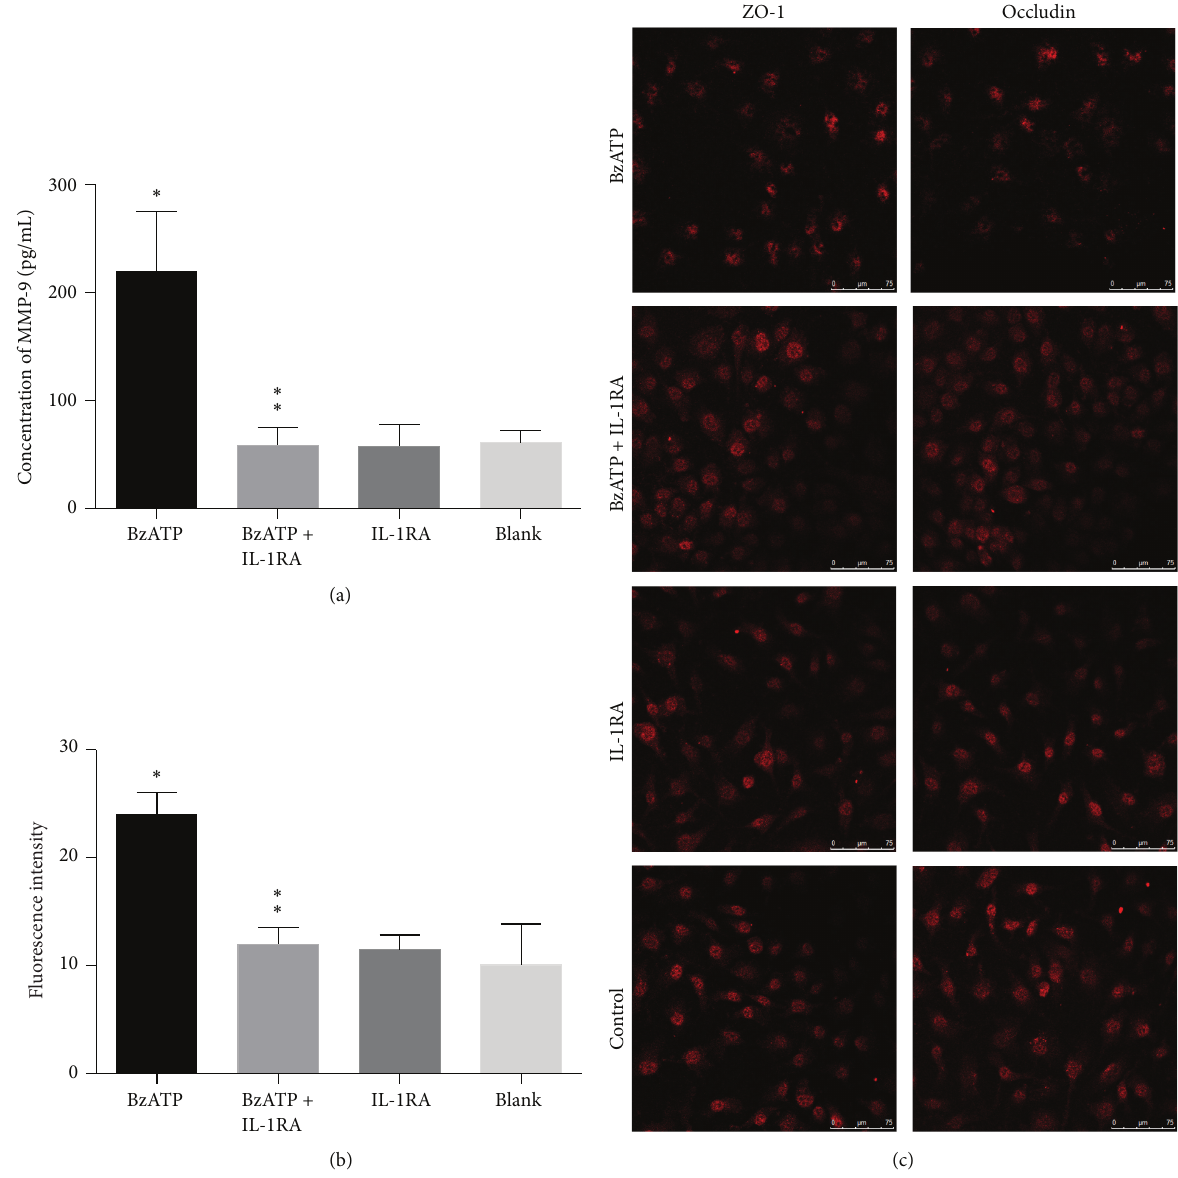
Figure 3: BzATP-induced tight junction disruption and hyperpermeability of endothelial coculture system were attenuated by IL-1 𝛽 inhibition. (a) The levels of MMP-9 were significantly higher in the BzATP groups than in the control groups ( ∗ 𝑃 < 0.05 ). IL-1RA treatment significantly reduced the level of MMP-9 versus vehicle group ( ∗∗ 𝑃 < 0.05 ). (b) BzATP induces hyperpermeability versus control groups ( ∗ 𝑃 < 0.05 ), which was decreased by IL-1RA in the coculture system ( ∗∗ 𝑃 < 0.05 ). (c) Confocal microscopy images of immunofluorescence staining of ZO-1 and occludin demonstrating the protective effect of IL-1RA against BzATP-induced tight junction disruption.